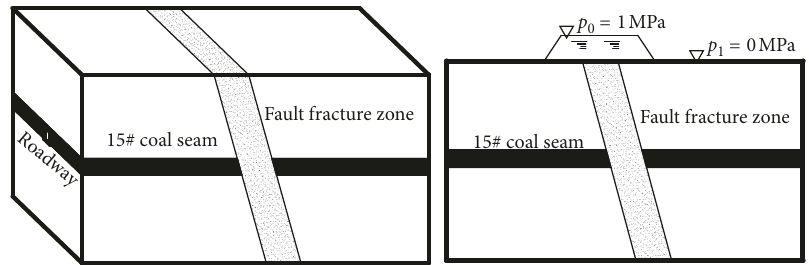
Figure 4: Numerical model of fluid-solid coupling in the roadway through fault.